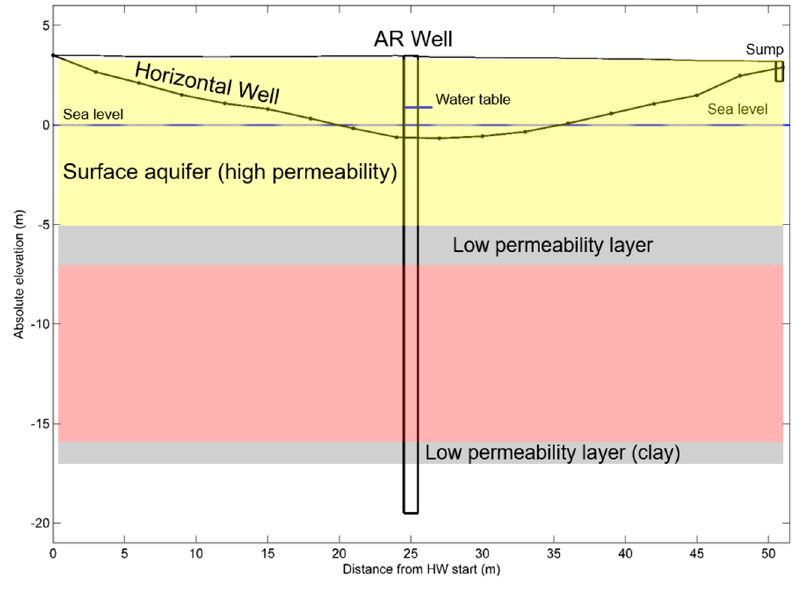
Figure 5. Managed aquifer recharge scheme of